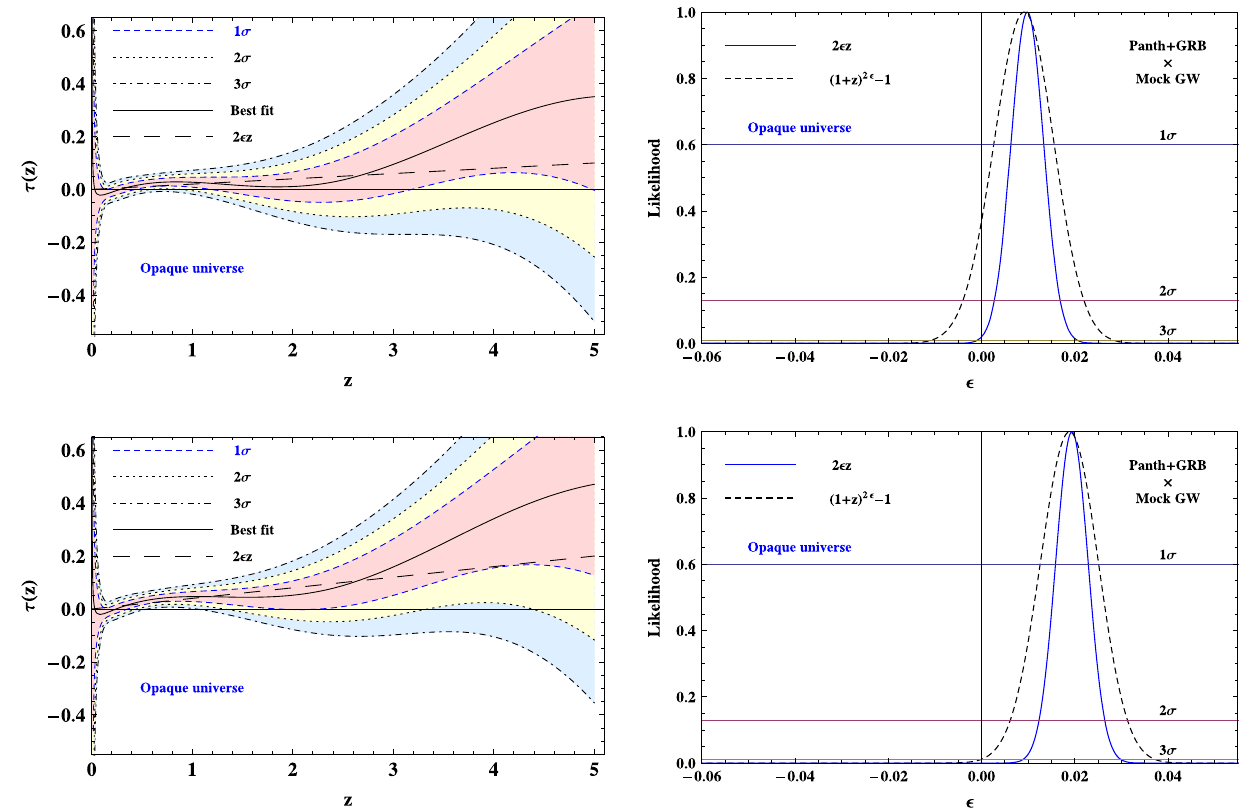
Fig. 3 The cosmic optical depth function τ( z ) (left panel) and the likelihood distribution functions (right panel) obtained from the combination of ‘Pantheon-like’ and ‘GRB-like’ data with a certain model of opacity in parametrization τ( z ) = 2 (cid:14) z with (cid:14) = 0 . 01 (top panel) and (cid:14) = 0 . 02 (bottom panel), respectively Table 1 Constraints on (cid:14) represented by the best fit value at 1 σ or 2 σ CL for each data